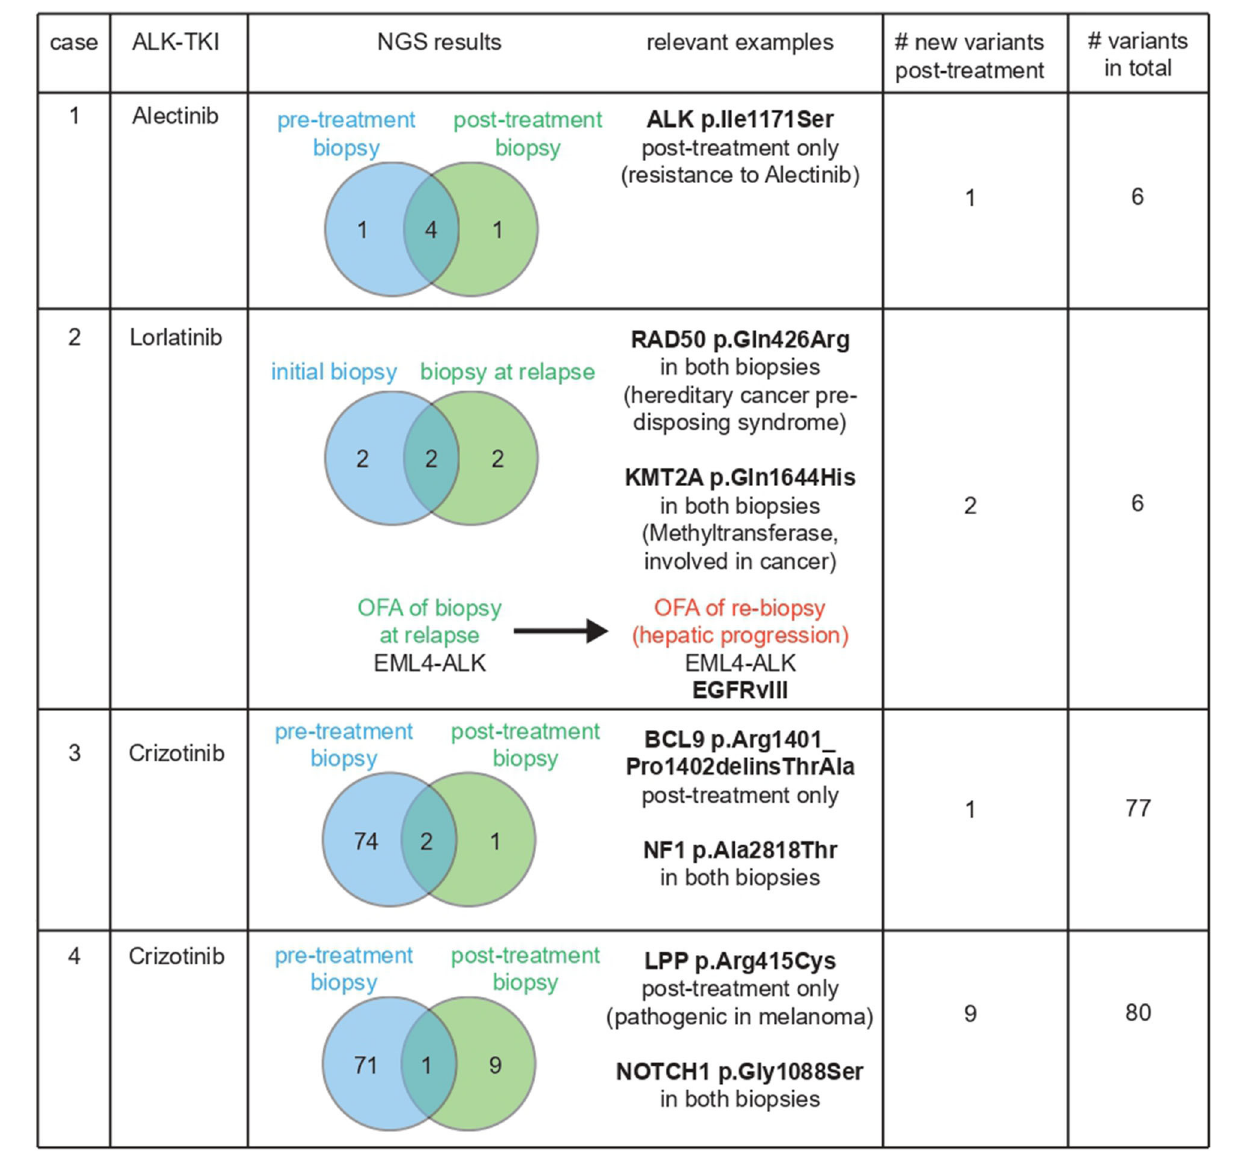
Frontiers in Oncology |